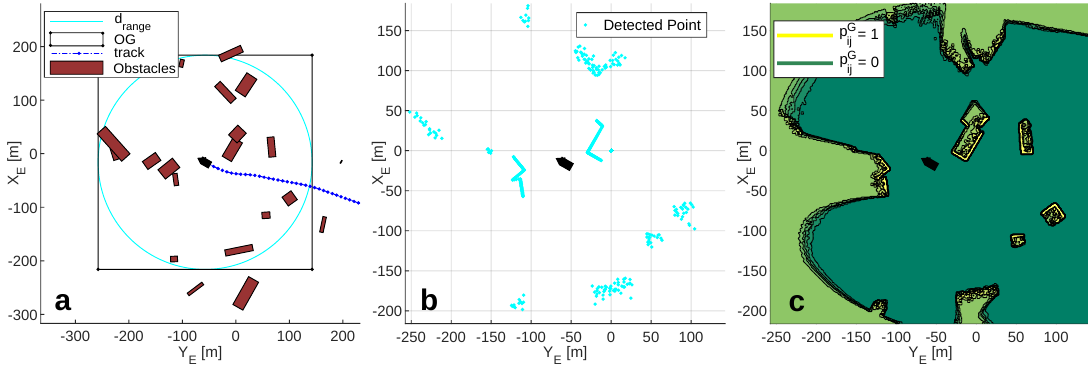
Figure 5. ( a ) Obstacle scenario. ( b ) LIDAR sensor measurements. ( c ) Occupancy probability